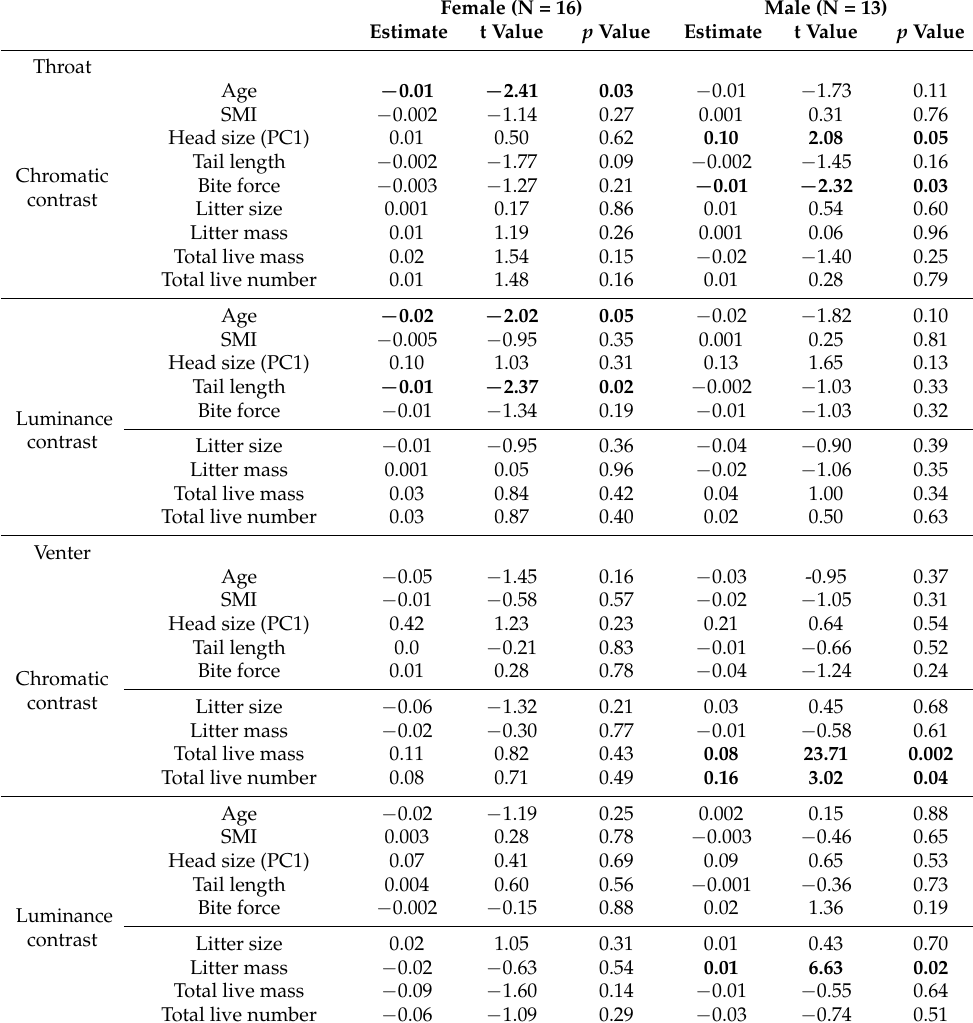
Table 3. Summary of a linear mixed model (LMM) examining correlation between colour conspicu- ousness in just-noticeable differences (JNDs) in relation to a lizard visual system for chromatic and luminance channels against background vegetation, individual quality-related traits and reproductive output by body region and sex. Bold indicates a significant association ( p <